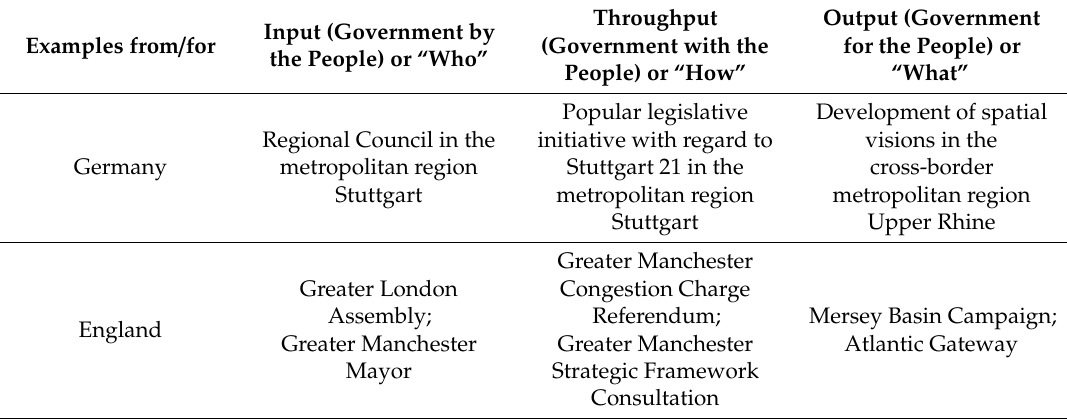
Table 1. Input, throughput, and output legitimation in metropolitan